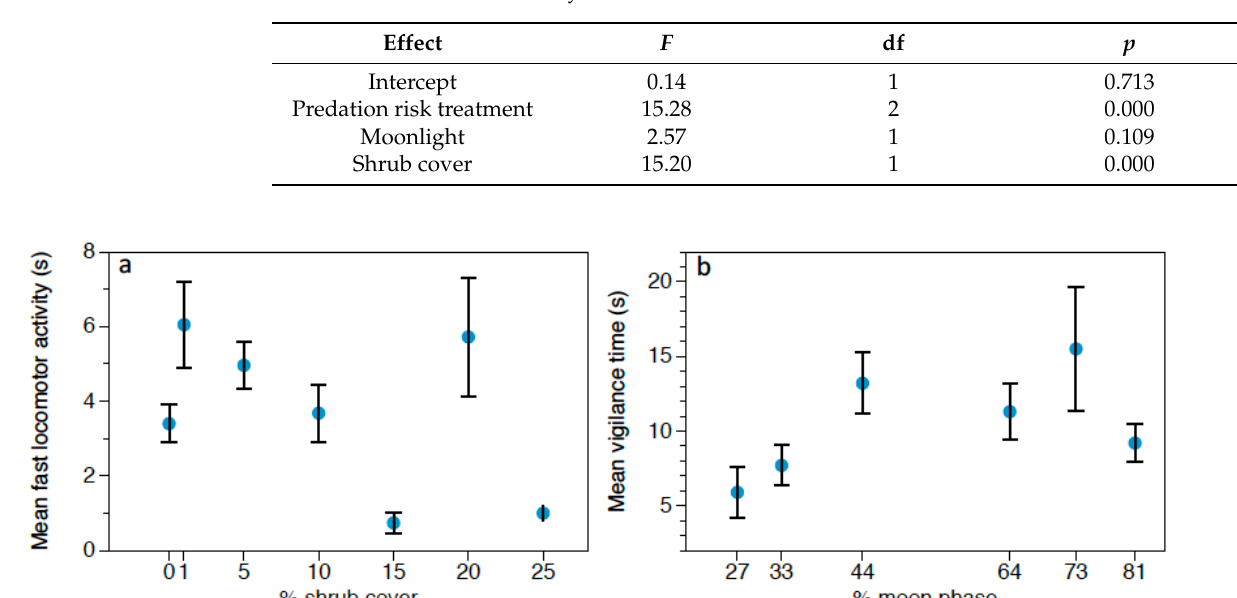
Figure 5. ( a ) Mean feeding time (s) ± SE, ( b ) mean fast locomotor activity (s) ± SE, and ( c ) mean slow locomotor activity (s) ± SE, displayed by R. rattus , depending on predation risk: G. nana calls (GN)/ S. rufipes calls (SR)/No vocalizations (NV). Number of events are in parenthesis. Table 10. Results of the GLM analyzing the effect of experimental and environmental factors on R. rattus fast locomotor activity.